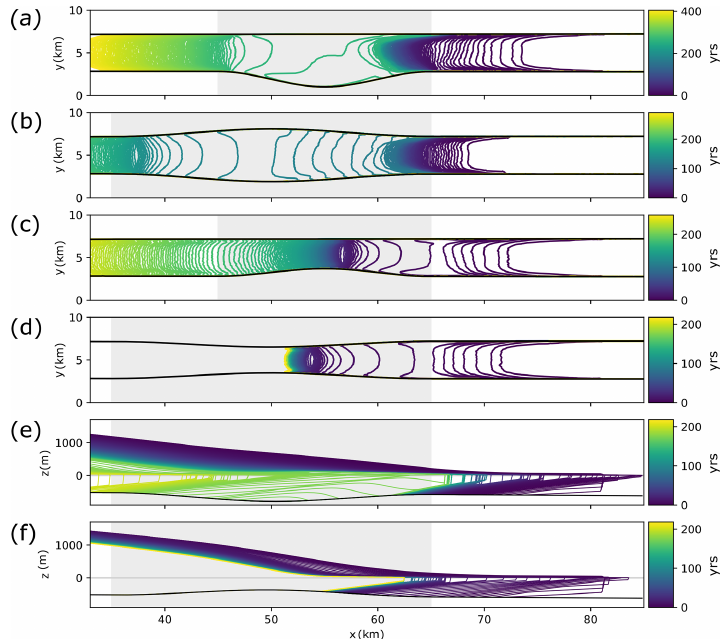
Figure A2. Retreat through asymmetric and longer perturbations. Annual grounding lines for lateral perturbations (a–d) , annual profiles through glaciers for basal perturbations (e, f) . Geometries shown are (with names referring to Table 2): (a) ByH1800_asy, (b) ByH900_lon, (c) ByH-900_asy, (d) ByH-675_lon, (e) BuH-240_lon, (f) BuH180_lon. Shaded areas indicate extent of geometric perturbation.